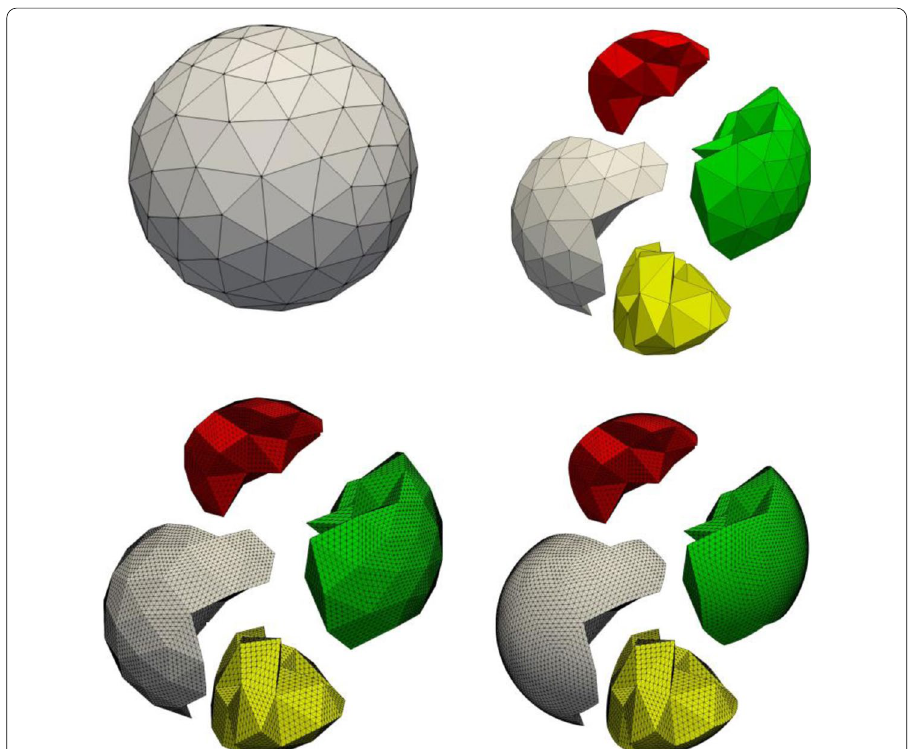
Fig. 8 An example illustrating the parallel mesh refinement workflow. a is the input coarse mesh. b is the partitioned result of the input mesh. c is the refinement result of ( b ). d is the final mesh after projecting new surface points onto the original CAD model. Note that a mesh deformation is carried on after projection to improve shape quality of volume